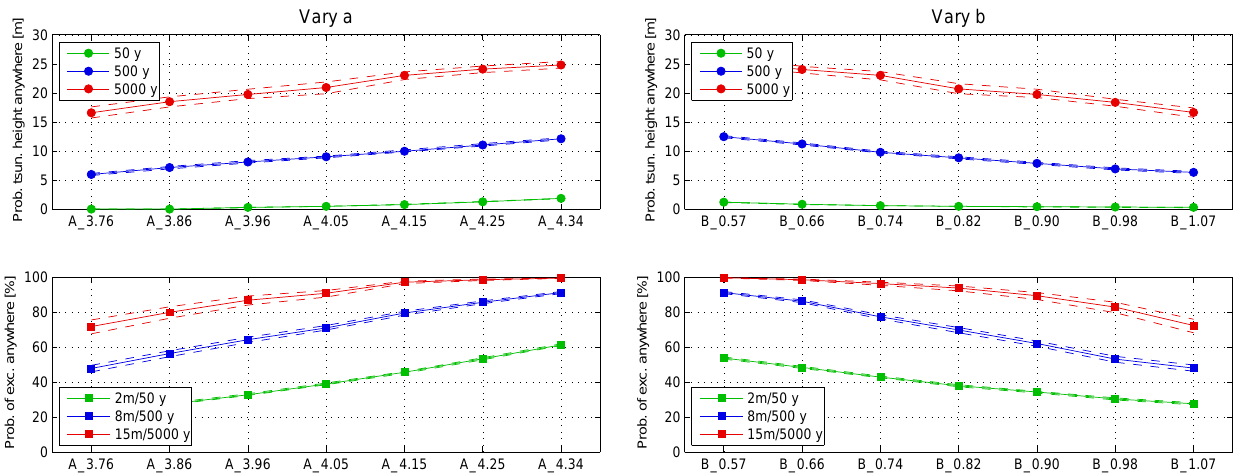
Figure 6. Influence on PTH (upper panels) and POE (lower panels) from varying a parameter (seismic rate) (left) and b parameter (right) around M =